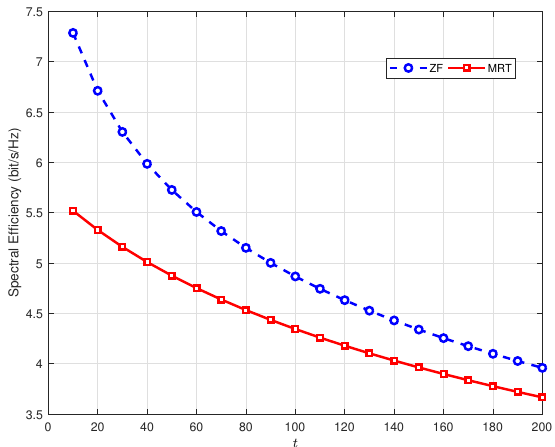
Figure 5. Spectral efficiency against t with MRT and ZF